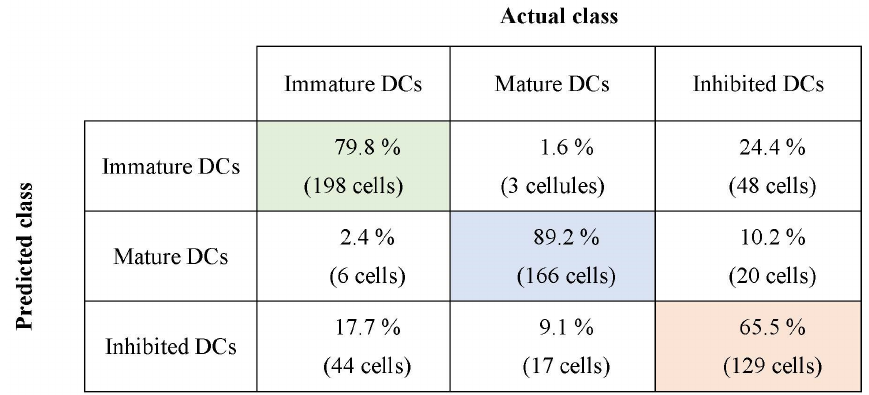
Figure 7. Confusion matrix for the three different classes of DCs using the FLD-SVM method.